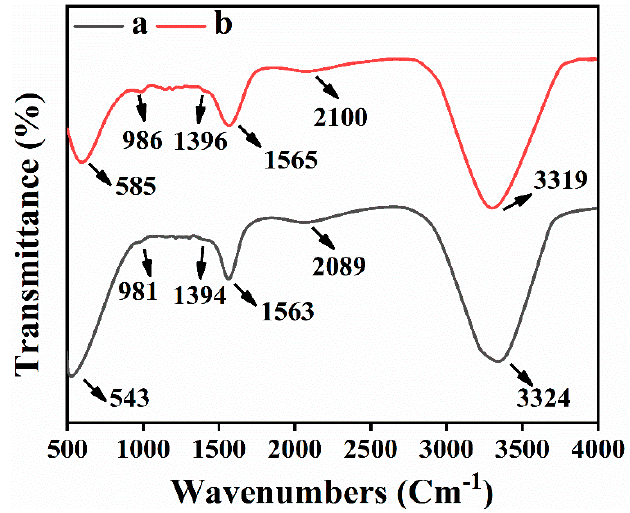
Figure 3. FTIR spectra of (a) leaf extract of R. communis (b) Silver nanoparticles synthesized by using 1% leaf extract of R. communis.